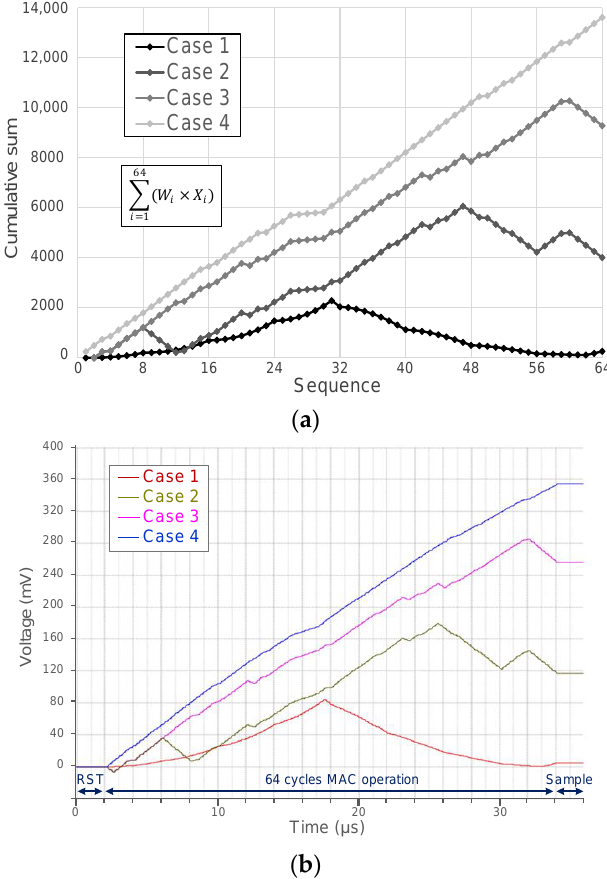
Figure 10. Simulated results of the analog matrix multiplier: ( a ) expected accumulated multiplier value for different input vector cases and ( b ) simulated differential output plotted in the same time scale. The proposed architecture consumes 1.5 µ W and shows MAC energy ( E MAC ) of 0.38 pJ at a 2 MHz Table 1. Output error for different input vectors.